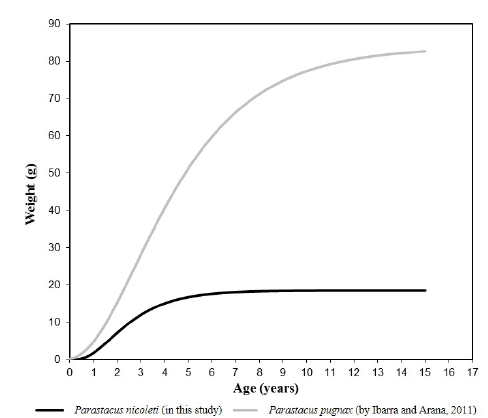
Figure 4. Comparison between length growth curves of Parastacus nicoleti and Parastacus pugnax adjusted to the von Bertalanffy (1938) model.